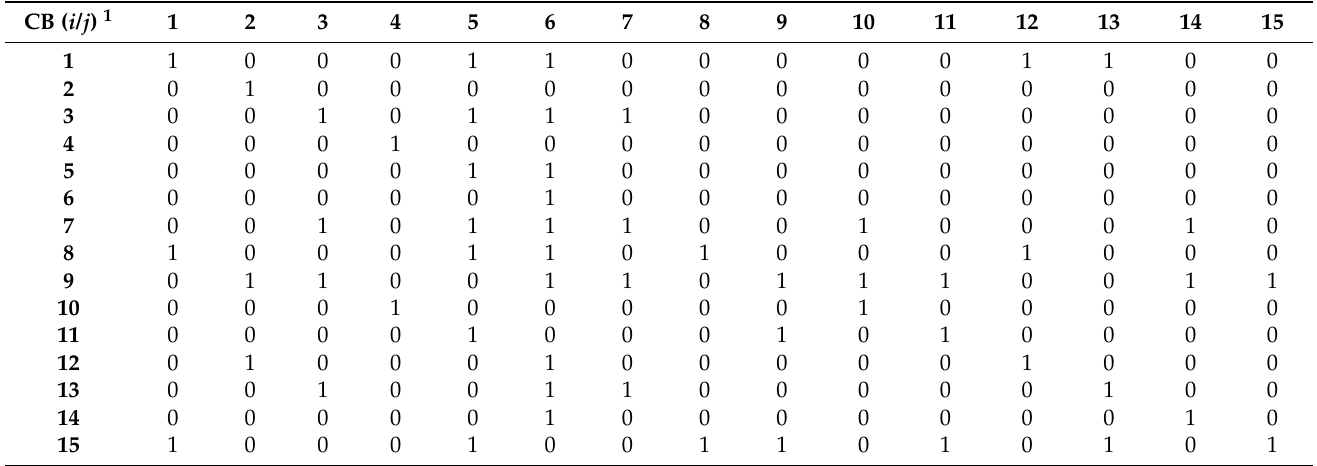
Table 5. Initial Reachability Matrix.